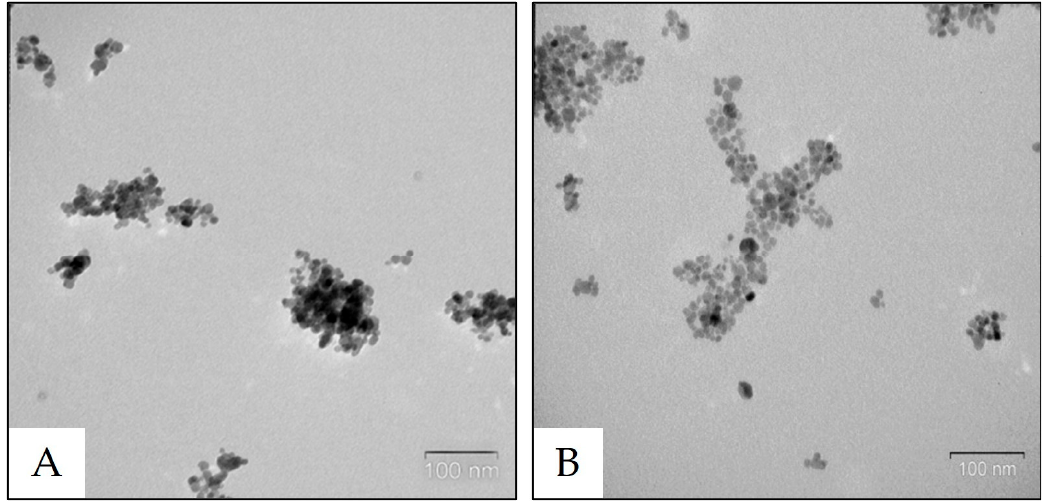
Figure 1. TEM images of MNP ( A ) and MNP_OA ( B ). The bar indicates 100 nm.